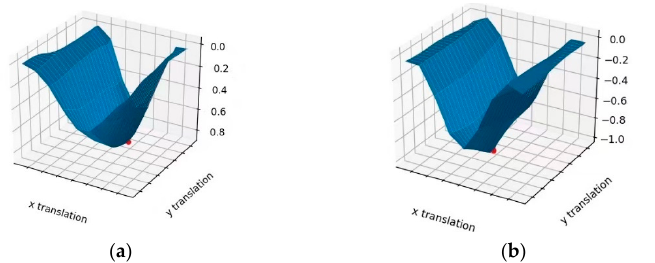
Figure 11. A graph of the similarity measurement function. ( a ) Normalized cross correlation; ( b ) local normalized cross-correlation based on Gaussian mixture model.